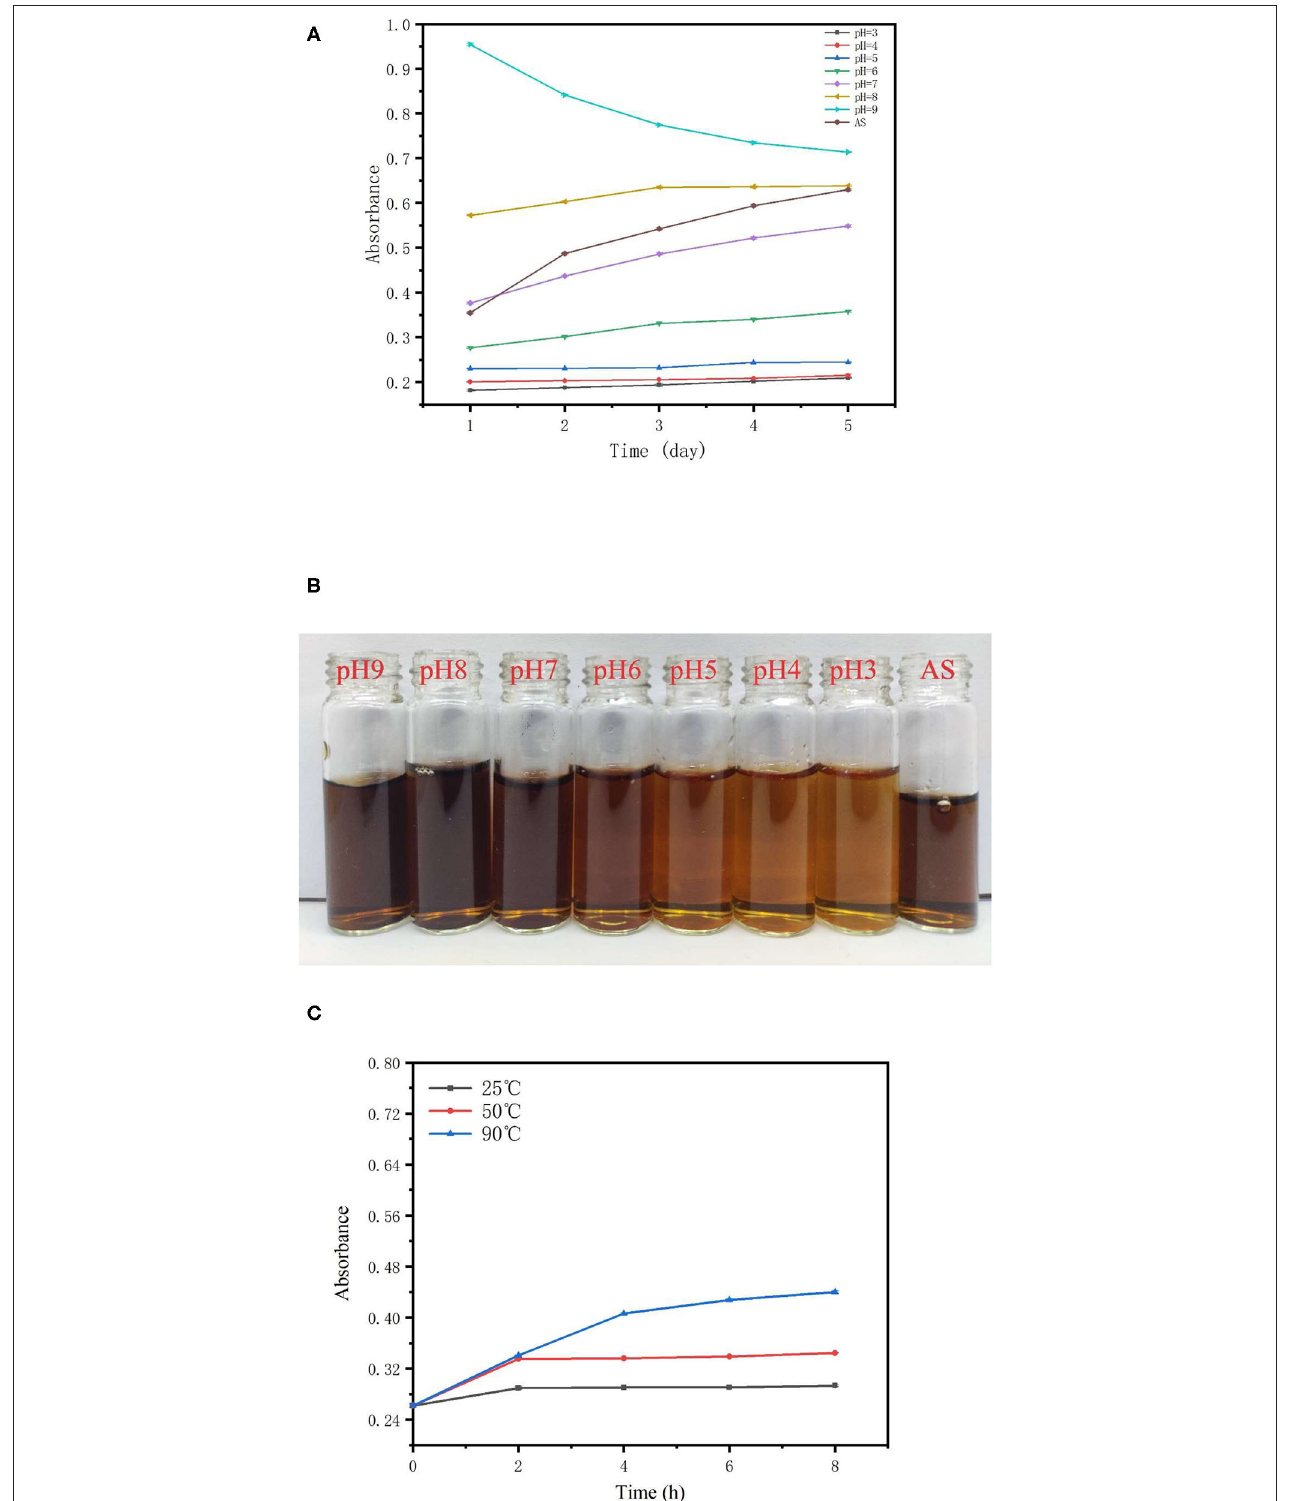
FIGURE 5 | Effects of different pHs and temperatures on the stability of TBs-E. (A) Change in the TBs-E absorbance curves in pH 3.0–9.0 solutions and a purified aqueous solution (AS) after 5 days of storage, (B) the color of newly prepared TBs-E in different pH and ultrapure aqueous solutions, and (C) change in the absorbance curves of TBs-E aqueous solutions stored at 25, 50, and 90 ◦ C for 8h.